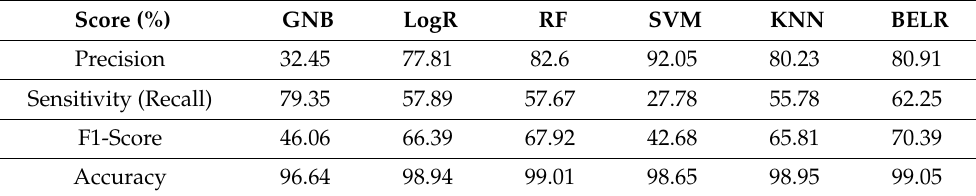
Table 3. The performance of comparison algorithms under certain